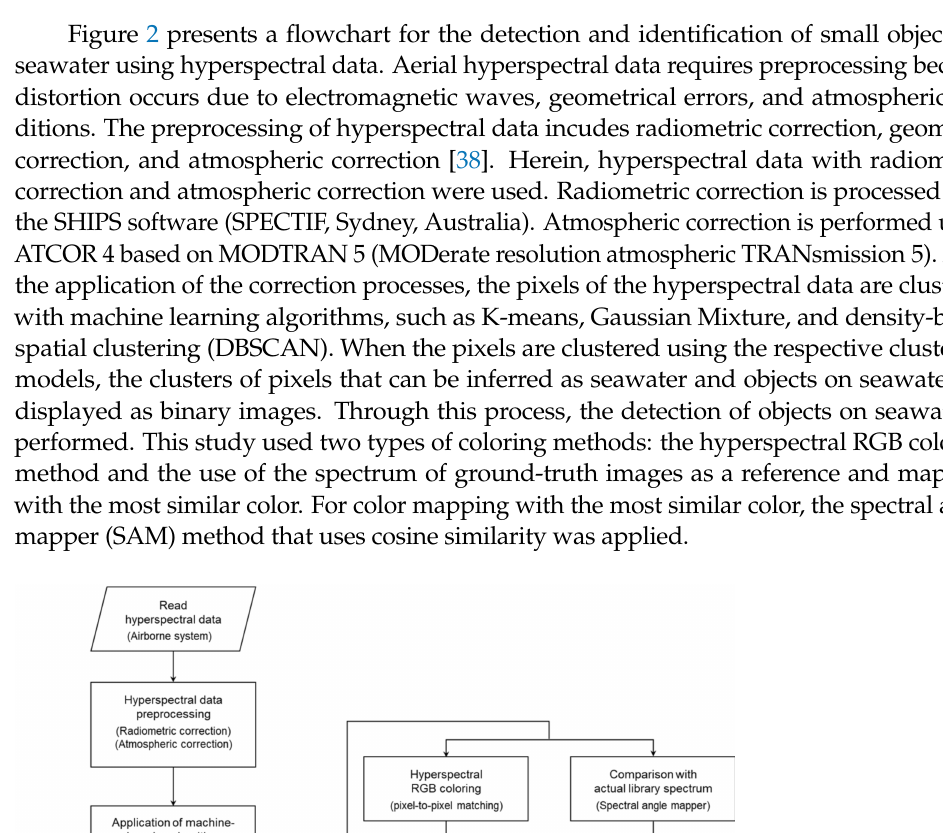
Figure 1. Schematic for the detection of small objects on seawater using aircraft. Objects on seawater are detected by scanning hyperspectral data using aircraft and clustering the scanned data using machine learning technology.